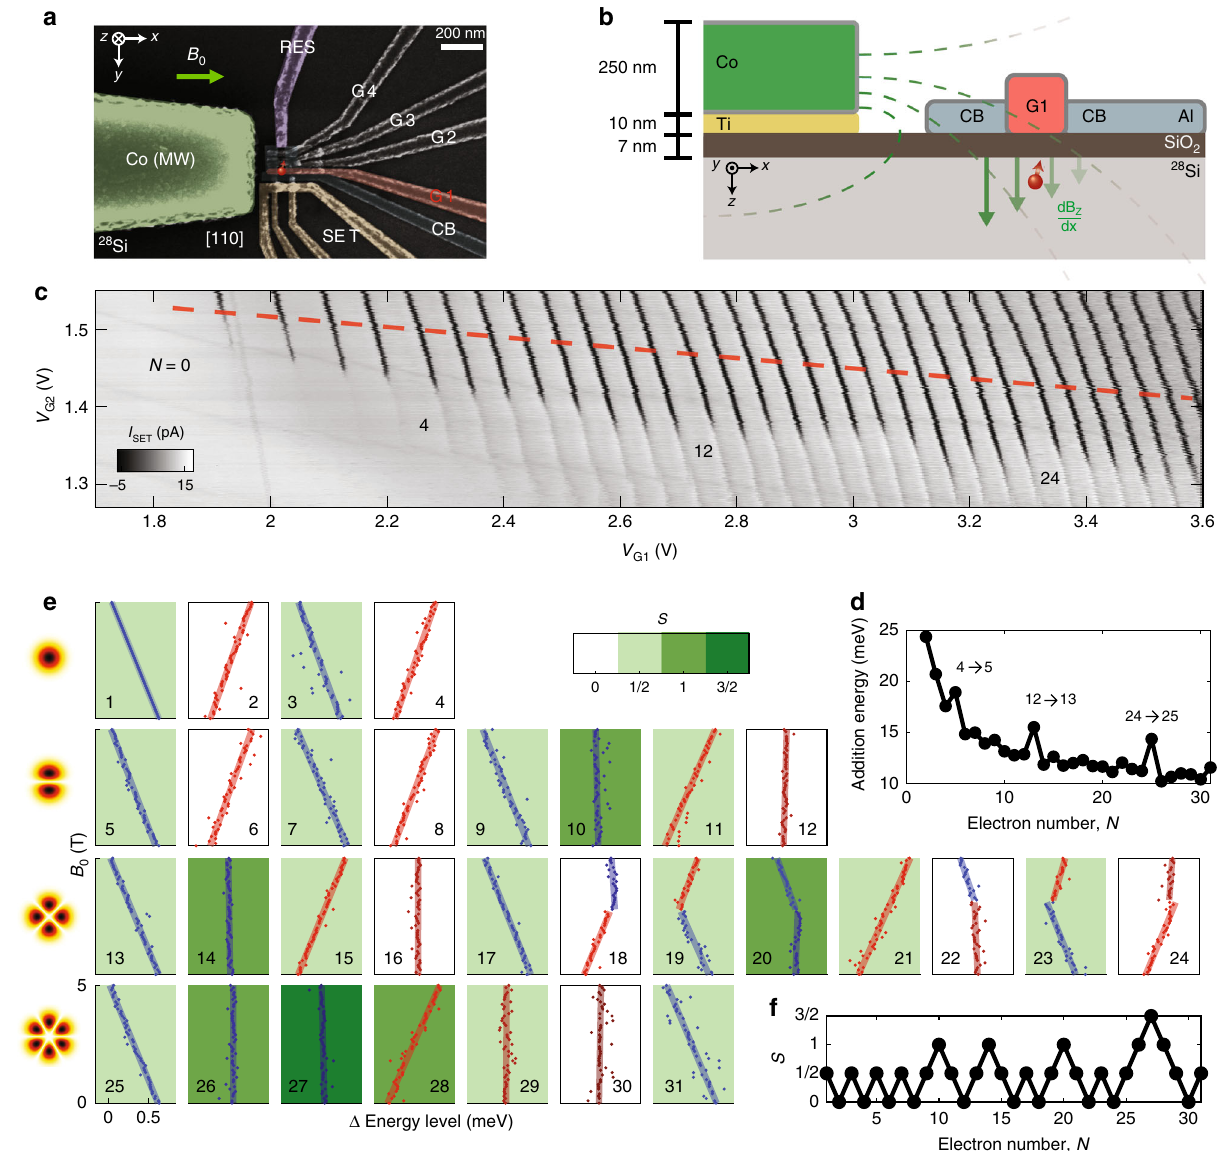
Fig. 1 Device overview and electron occupancy measurement. a False-coloured SEM image of a nominally identical device to that reported here. A quantum dot is formed under gate G1 (red), in the location marked by the red symbol. Gate RES is connected to an n-doped reservoir to load/unload electrons to/from the quantum dot, with tunnel rates controlled by G2, G3 and G4. Gate CB serves as a con fi nement barrier. The cobalt (Co) structure at the left of the image acts as both a micromagnet and electrode for EDSR control (green). b Cross-sectional schematic of the device, fabricated on a puri fi ed Silicon-28 epi-layer (800 ppm). c Charge stability map of the quantum dot at B 0 = 0 T, produced by plotting the pulsed lock-in signal from SET sensor I pulse vs V G1 and V G2 . A square wave with peak-to-peak amplitude of 2 mV is applied to G1 for lock-in excitation. Dynamic compensation is applied to the SET sensor to maintain a high read-out sensitivity. Electron numbers N for full shells are marked on the diagram. d Charging energies along the red line in ( c ) in the tightly con fi ned regime. e Magnetospectroscopy of the fi rst 31 electrons occupied in the quantum dot, up to B 0 = 5 T, with background colour of each plot representing spin state S at B 0 = 0 T. Change in addition energies with magnetic fi eld are measured and fi tted with straight lines. Since the charging energy is measured only from the second electron, the fi rst electron is depicted by a straight line with no data. Each row of the array of plots belongs to the same shell, while each column has the same number of valence electrons in its outershell. The cartoon on the left gives an example of the electron wavefunction for each shell. f Spin state of each electron occupancy extracted from ( e